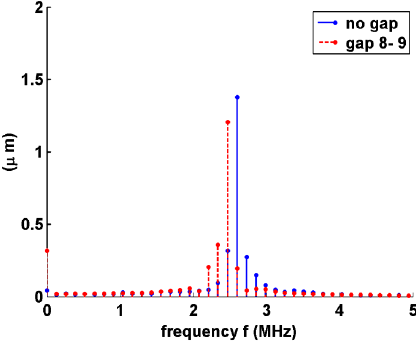
FIG. 19. Fourier analysis of the oscillation of an ion cloud interacting with a full bunch train and a bunch train with 100 gaps between each 900th and 999th position of the